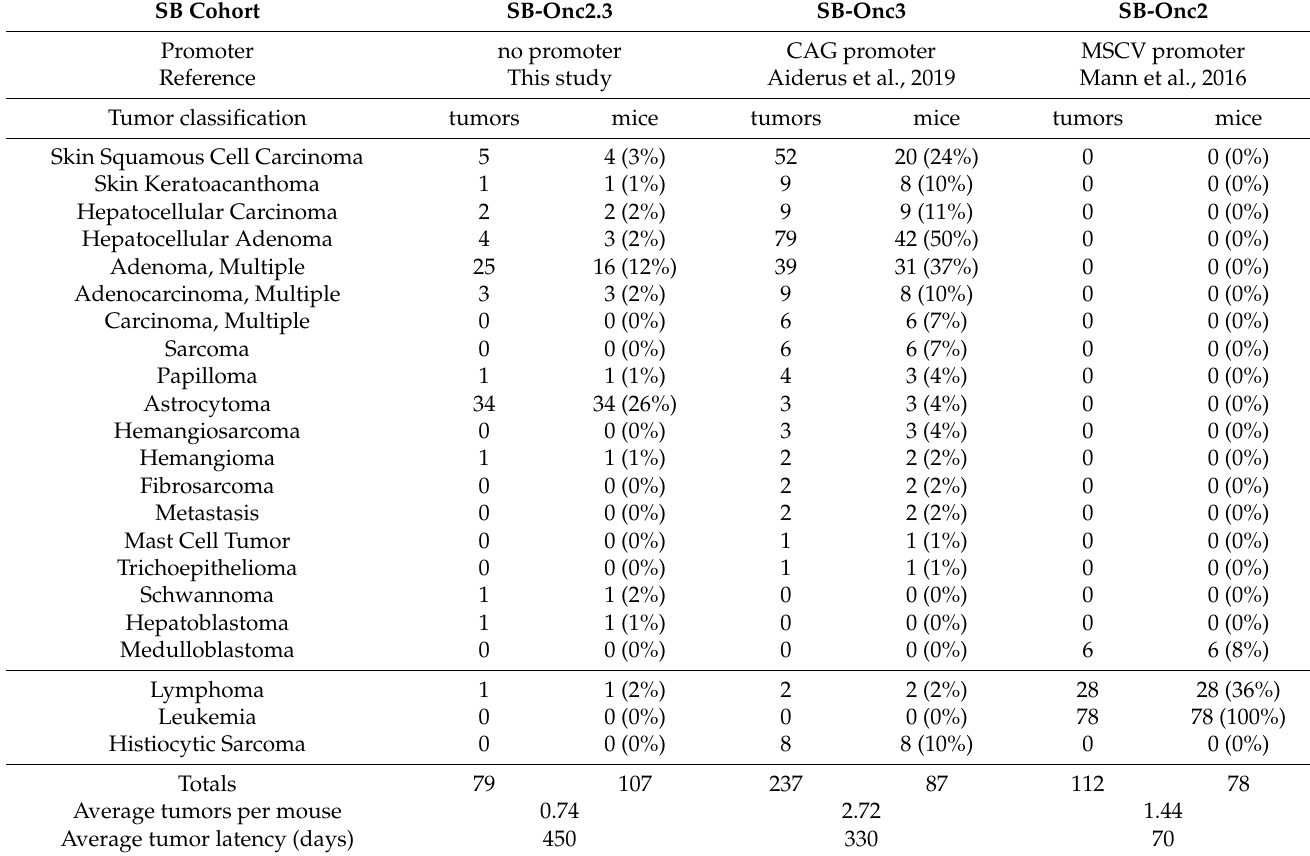
Table 1. SB allele-specific tumor spectrum by whole-body, transposon-mediated mutagenesis in wild type mice. SB